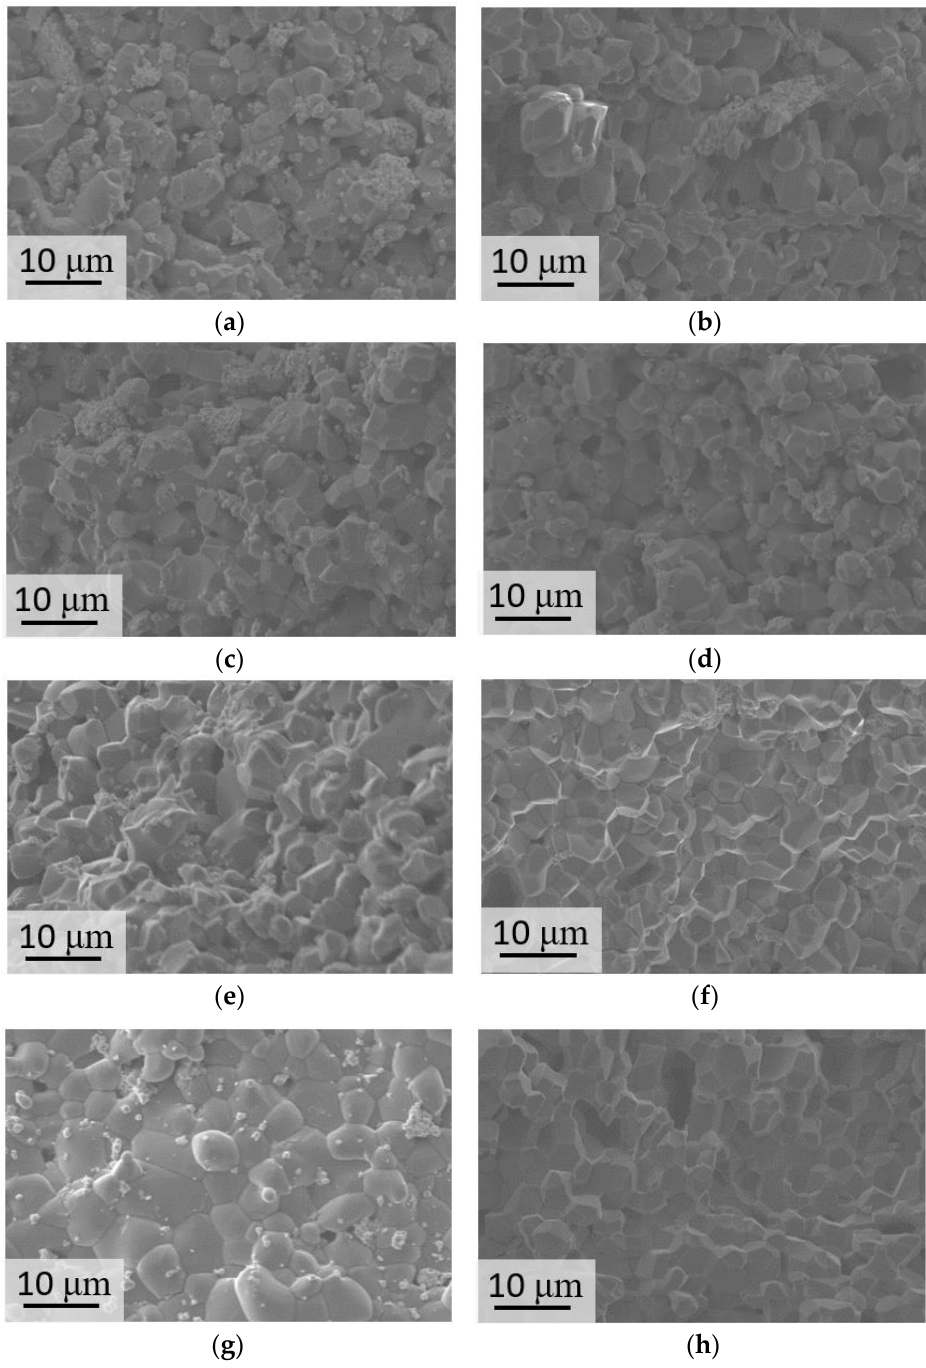
Figure 7. SEM images (SE2-type) of the samples: ( a ) Mg5NaY-TZP, ( b ) Mg5KY-TZP, ( c ) Mg10NaY-TZP, ( d ) Mg10KY-TZP, ( e ) Mg15NaY-TZP, ( f ) Mg15KY-TZP, ( g ) Mg20NaY-TZP, ( h ) Mg20KY-TZP.